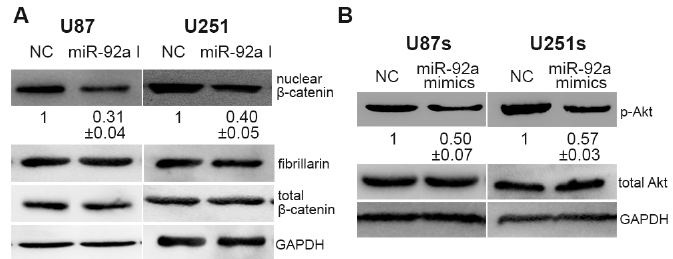
mutant type 3 ′ UTR of CDH1 and Notch-1. Each bar represents the mean of three independent experiments. ** indicates p < 0.01.